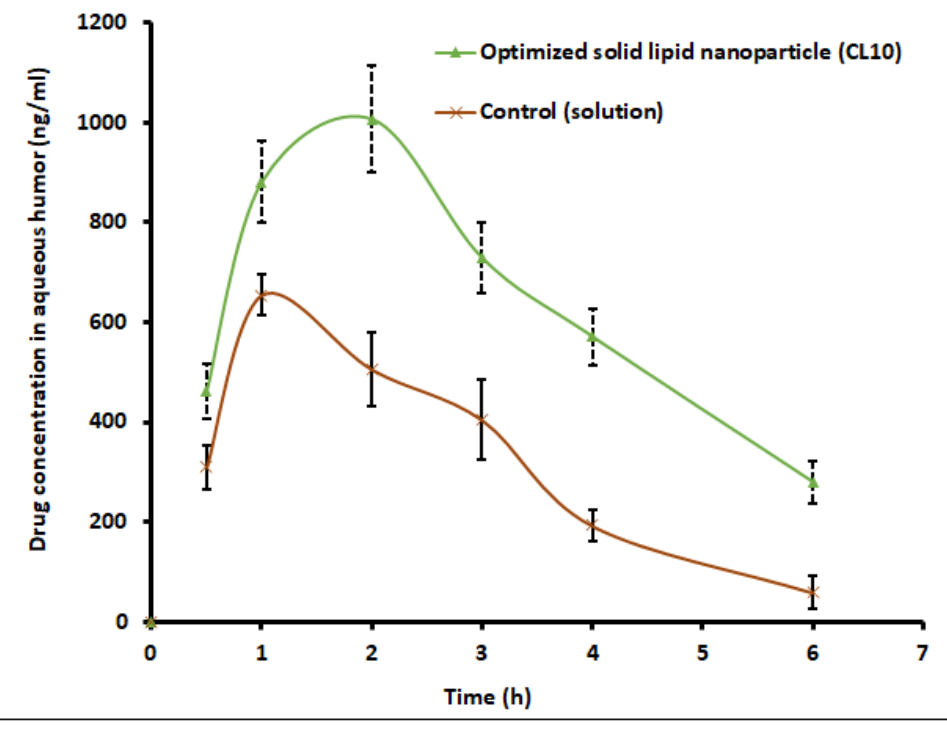
Figure 13. Ocular pharmacokinetics profile of clarithromycin after topical application of solid lipid nanoparticle (CL10) and control (solution) in rabbits. Data represented are mean ± SD ( n = 6).